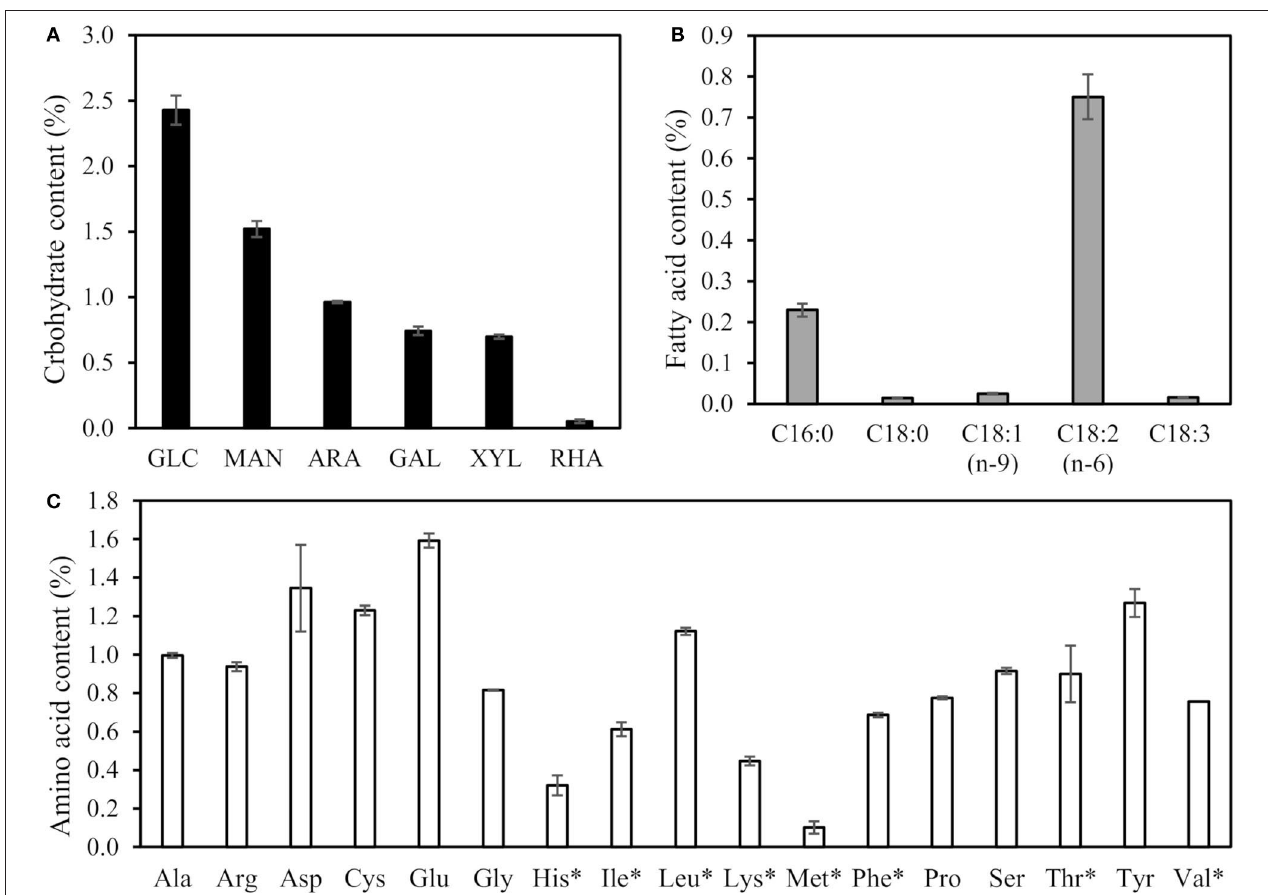
FIGURE 2 | Carbohydrate (A) , fatty acid (B) , and amino acid composition (C) of dry biomass (%). The total carbohydrate, fatty acid, and amino acid contents of the dry biomass were 6.4, 1.0, and 14.8%, respectively. Essential amino acids indicated